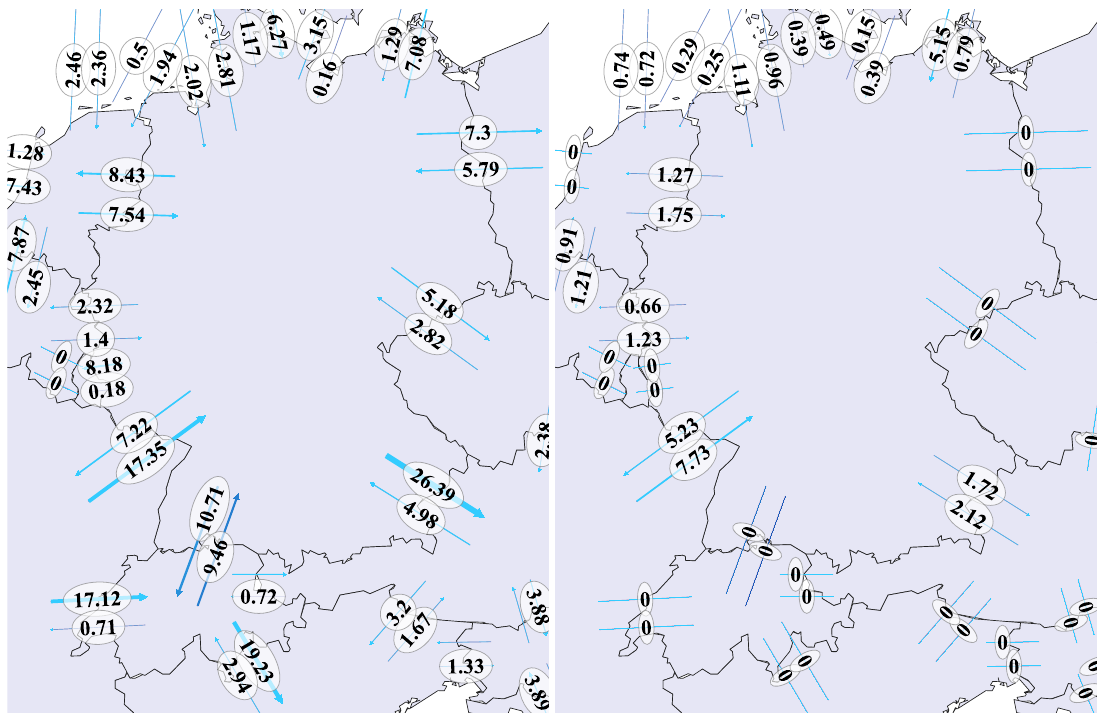
Figure A5. Cumulative annual CB trading volumes on DA ( left ) and ID ( right ) market in [TWh] between Germany and neighboring markets for scenario